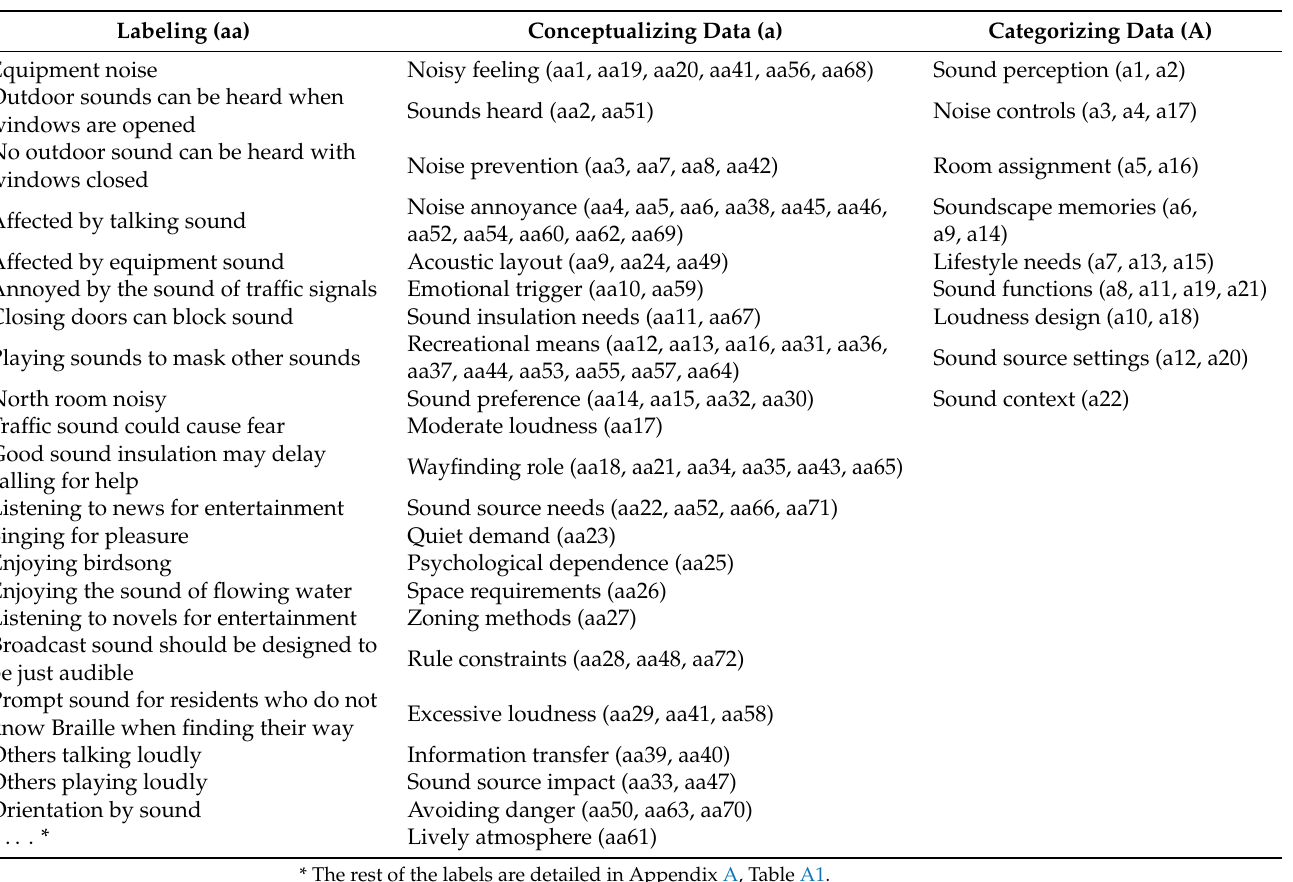
Table 2. Open coding scheme of the sound